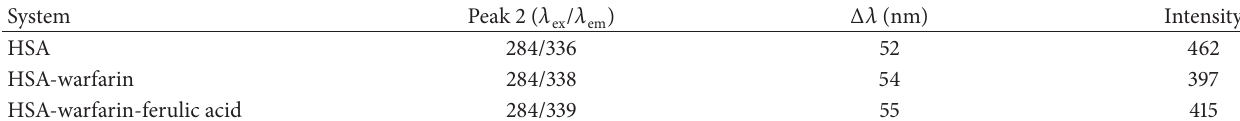
Table 4: Contour spectra characteristics of HSA, HSA-warfarin, and HSA-warfarin-ferulic acid systems.